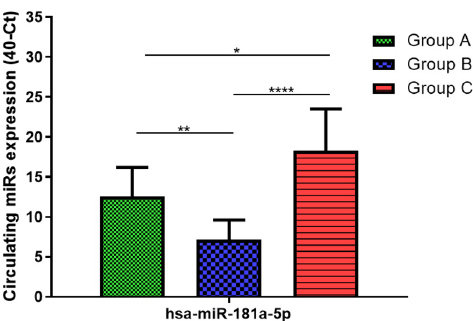
Figure 4. Serum levels of hsa-miR-181a-5p in HNW (Group A), MANW (Group B) and HNAO (Group C). Results were shown as means ± SD. The statistical tests used in these analyses were one-way analysis of variance using Kruskal–Wallis test followed by Dunn’s Multiple Comparison Test. * p < 0.05, ** p < 0.01, **** p < 0.0001.